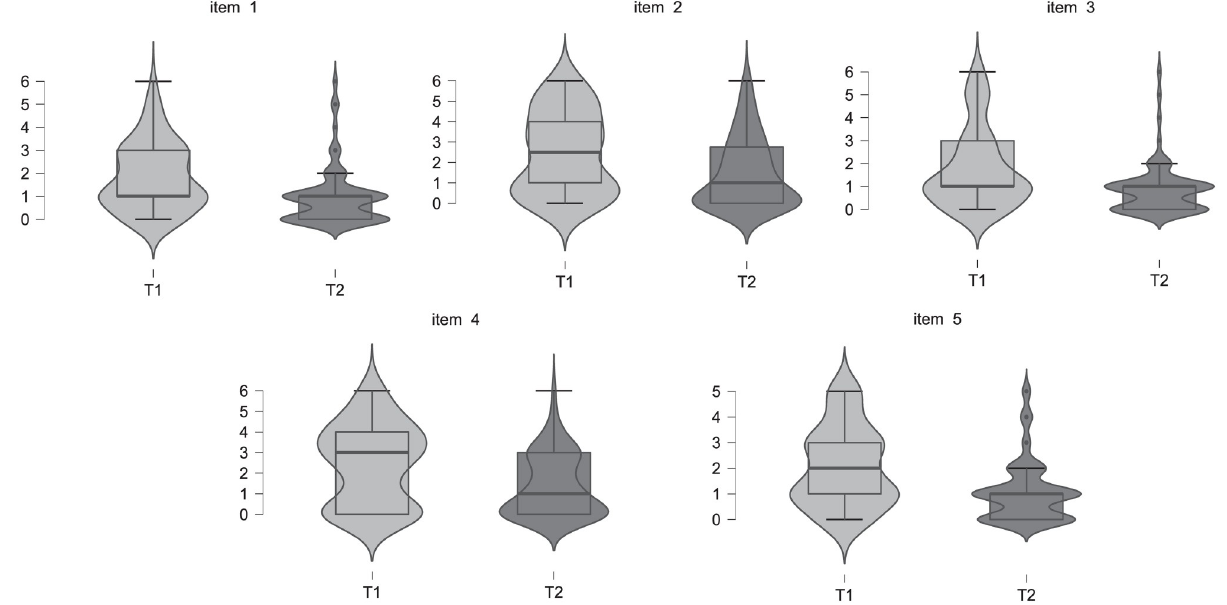
Fig 1. Violin plot for each item of the PDCS: Longitudinal perspective (across T1 and T2).